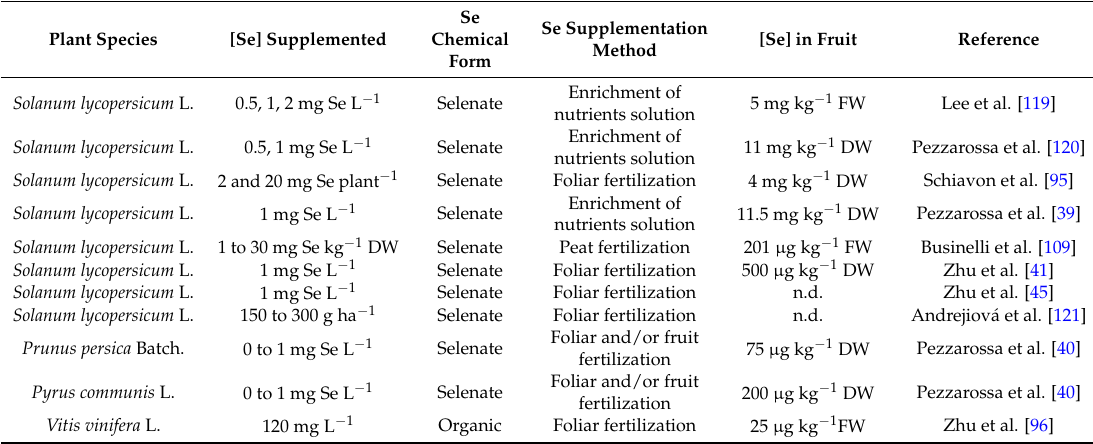
Table 3. Selenium (Se) accumulation in fruit in relation to the concentration, the chemical form of Se supplemented to plants, and the method of Se